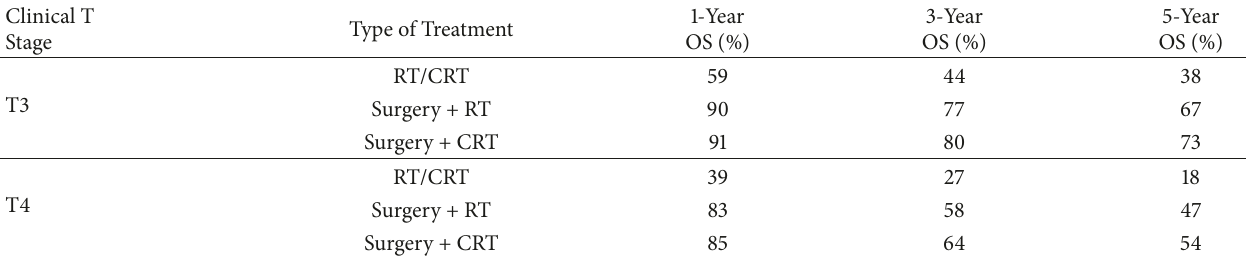
Table 4: Overall survival rate of LC by T-classification (T3, T4) and treatment among patients diagnosed with laryngeal cancer, South of Iran,